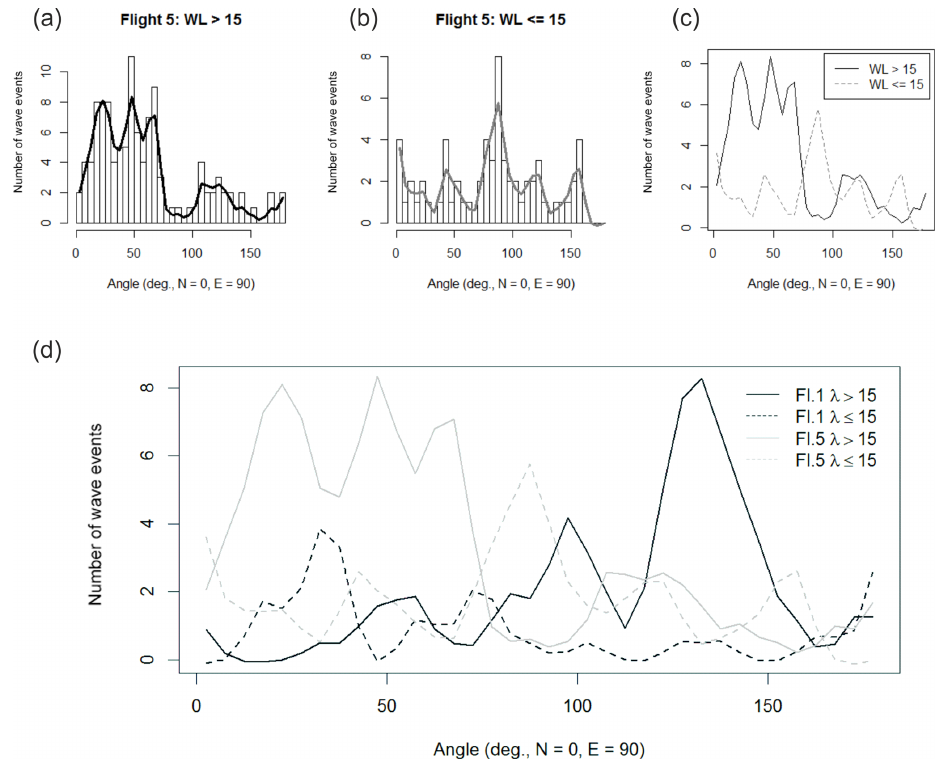
Figure 12. Same as Fig. 9 but for flight 5. In this case, the results for both wavelength ranges are qualitatively stable for different n and t (the smaller n and t , the higher the absolute values). (d) shows the direct comparison of the results of both flights.